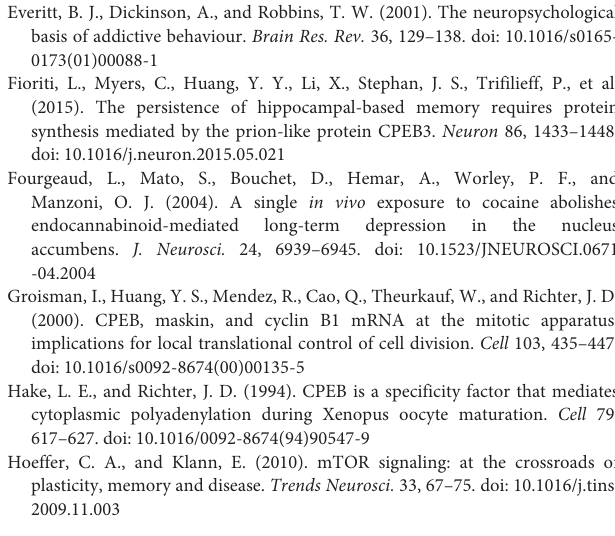
FIGURE S1 | CPEB1 and CPEB3 targets are selectively upregulated by cocaine. (A) CPEB2 levels are not increased by cocaine injection. (B) CPEB4 levels are significantly increased after cocaine injections ( n = 4, p < 0.01), but (C) CPEB4 targets are not, either in WT or DNCPEB mice, suggesting that CPEB4 is not under CPEB1 translational control (ANOVA, not significant). * p < 0.05, ** p < 0.01. FIGURE S2 | Dominant-negative DN-CPEB mice express a mutant, truncated CPEB1 that can bind to FosB 3 (cid:48) UTR. (A) DN-CPEB mice specifically express the TetO transgene in both hippocampus and striatum as shown by immunoblot with anti-Flag antibody. (B) CPEB3 mRNA is upregulated after long-term exposure to cocaine. The increase in CPEB3 protein expression 2 h after an acute cocaine treatment is transcriptionally dependent. RT-PCR experiments reveal significant differences in CPEB genes upregulation 30 min following cocaine exposure ( n = 4, p < 0.01, t -test). (C) The minimum free energy (MFE) structure of FosB 3 (cid:48) UTR is shown. The CPE element (UUUAU) recognized by CPEB1 is highlighted in pink. The CPE is also part of a stem-loop structure. The MFE structure was obtained with the software RNA fold